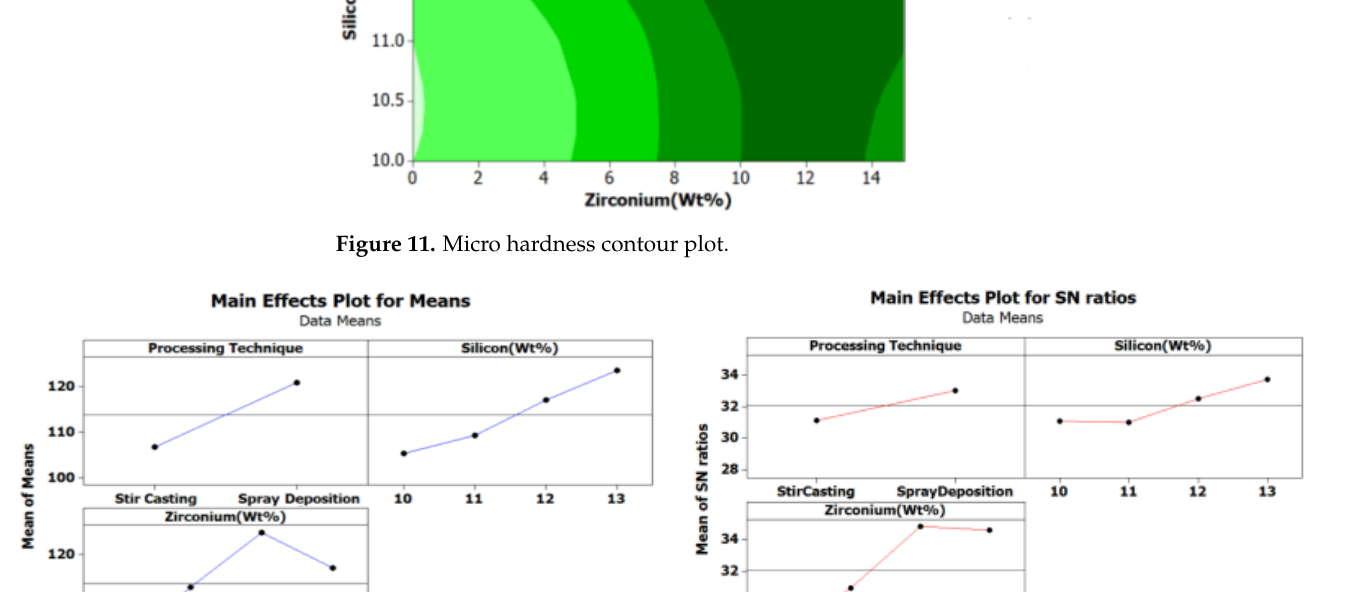
Figure 11. Micro hardness contour plot.